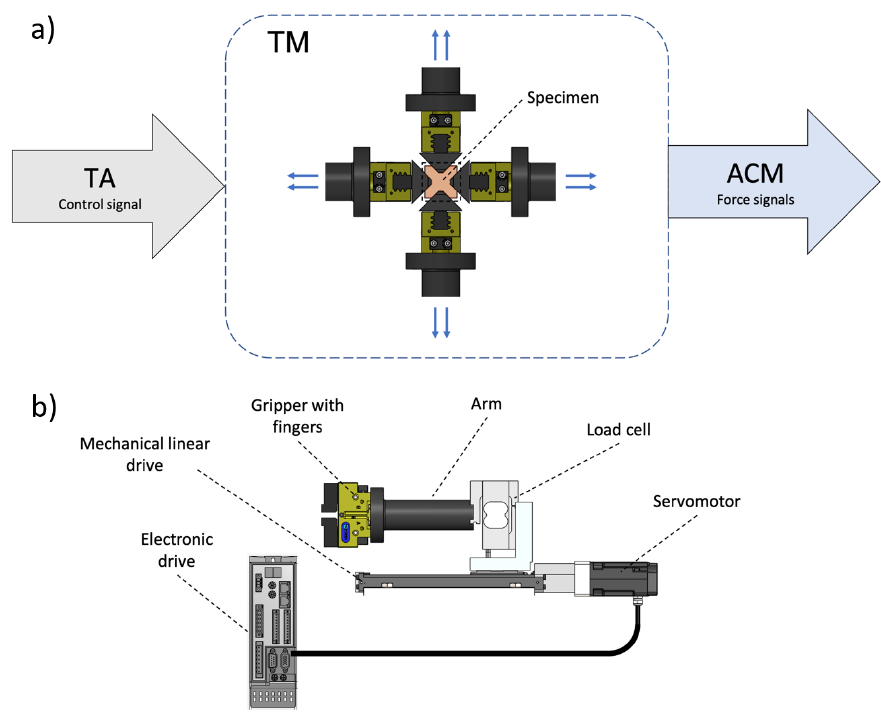
Figure 2. Tensile module (TM) communication with the tension application and acquisition module ( a ). Hardware components of a single arm of TM ( b ).